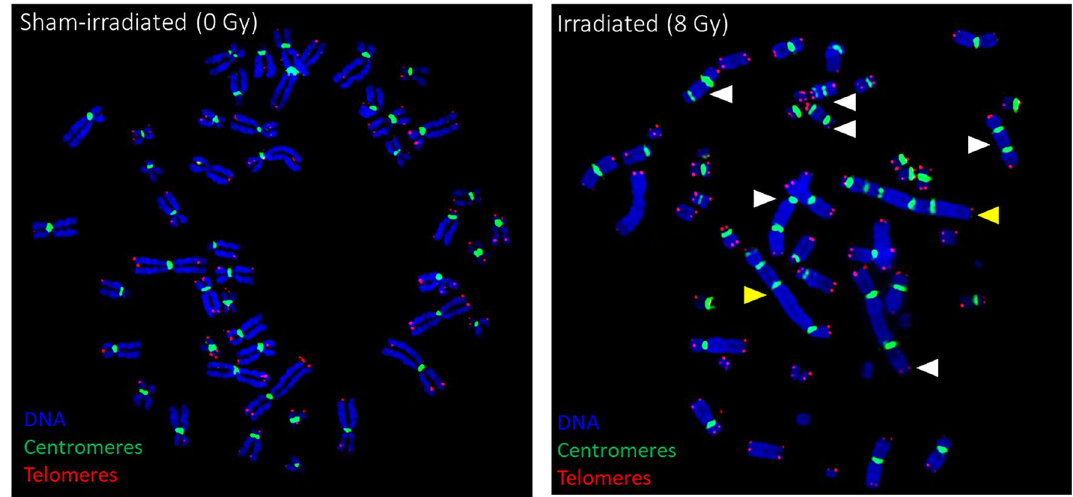
Figure 13. PNA-FISH-based detection of dicentric chromosomes: representative images of control (left) or irradiated to 8 Gy (right) lymphocytes. Aberant chromosomes are indicated by white (dicentrics, centromere number = 2) or yellow (multicentrics, centromere numbers > 2)